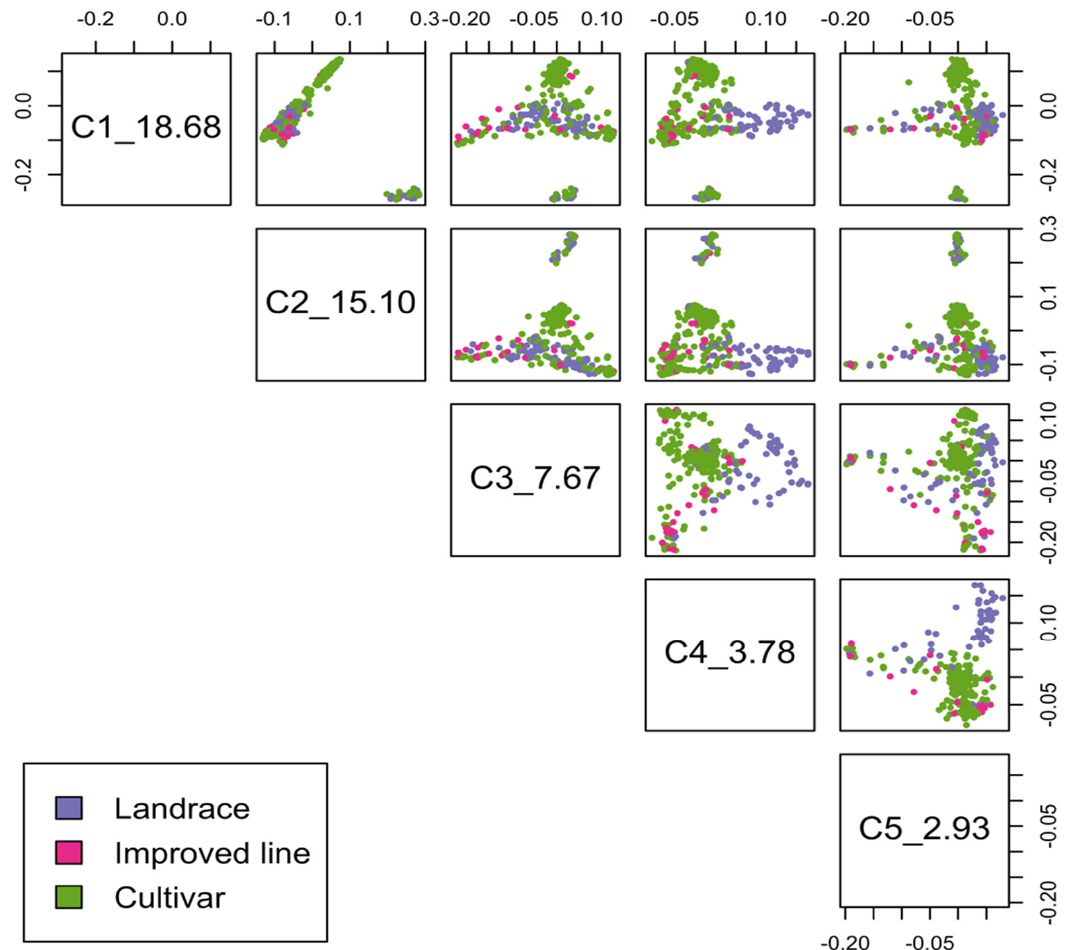
Figure 3. MDS plot by population type for 495 barley samples with 14,015 SNP markers in plink1.9 software.